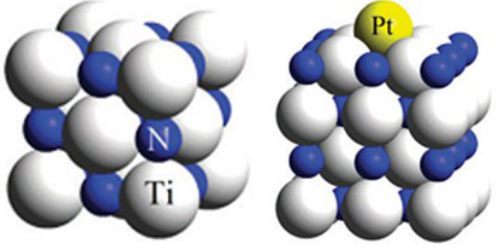
Figure 4. Crystal structure of TiN and the atomic structure model of Pt embedded on an N-vacancy site [93] (adapted from this reference with the permission of RSC